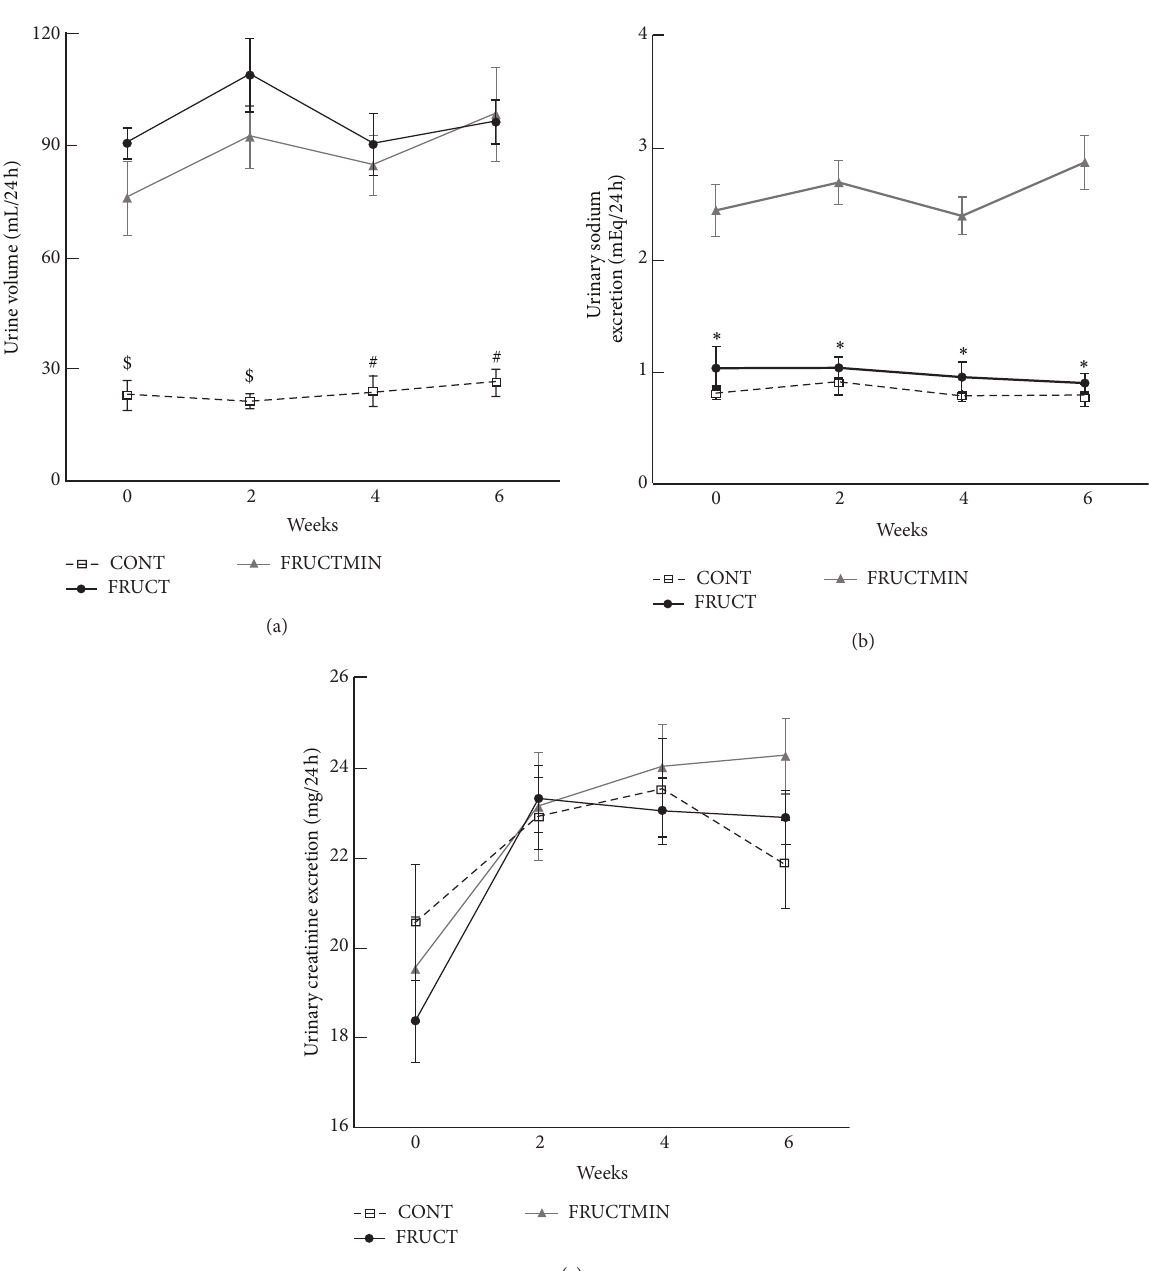
Figure 3: (a) Urine volume (mL/24h; 𝑛 = 7 ; $ 𝑃 < 0.01 CONT versus FRUCT and 𝑃 < 0.05 CONT versus FRUCTMIN; # 𝑃 < 0.01 CONT versus FRUCT and FRUCTMIN), (b) urinary sodium excretion (mEq/24h; 𝑛 = 6 -7; ∗ 𝑃 < 0.01 FRUCTMIN versus CONT and 𝑃 < 0.05 for FRUCTMIN versus FRUCT), and (c) urinary creatinine excretion evolution (mg/24 h; 𝑛 = 6 -7), every other week during the first 6 weeks of the dietary intervention. Results were expressed as mean ± standard error of the mean. CONT: control; FRUCT: 10% fructose in tap water; FRUCTMIN: 10% fructose in natural mineral-rich